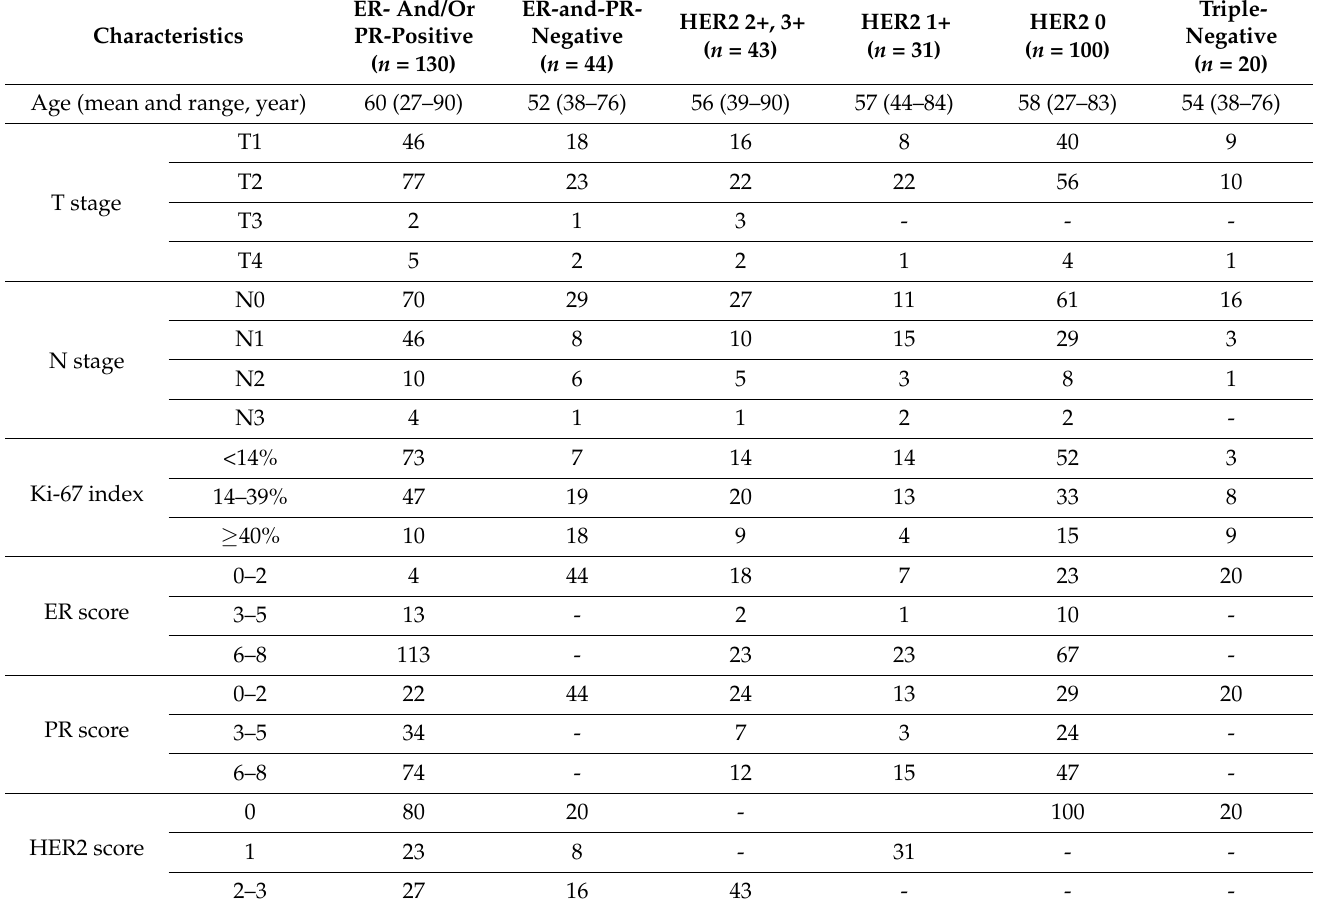
Table 1. Characteristics of the breast tumors under